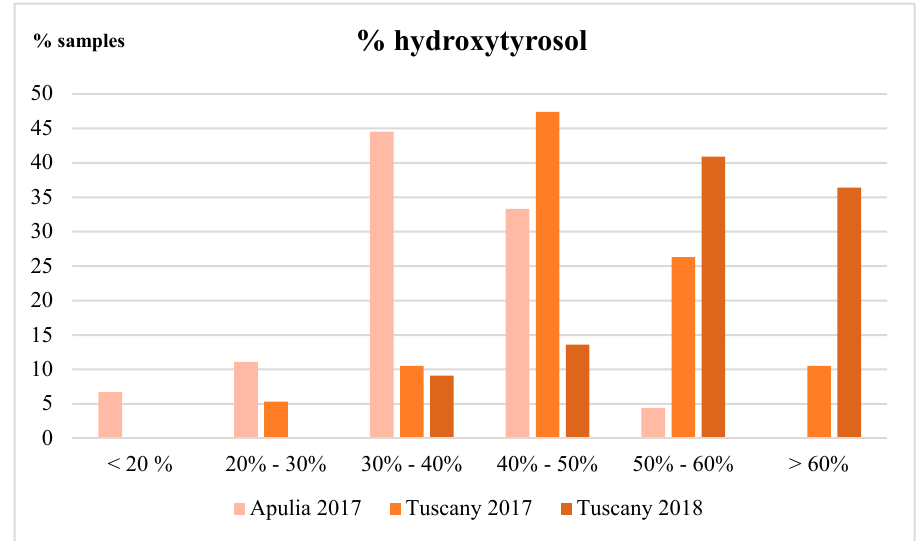
Figure 4. Evaluation of the percentage of hydroxytyrosol on the sum of total hydroxytyrosol + tyrosol. The chart reports the percentage of samples with different ranges of percentage of hydroxytyrosol for the sample from Apulia 2017, Tuscany 2017 and Tuscany 2018.